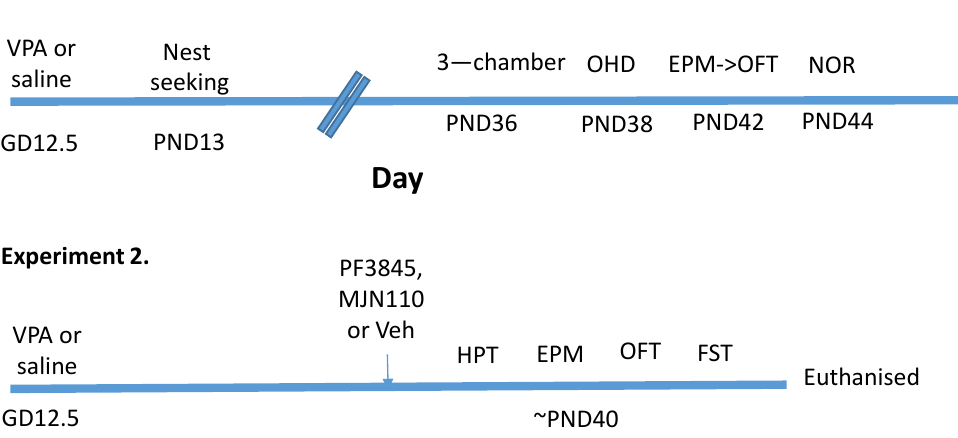
Figure 5. Schematic of the experimental design for the behavioural characterisation of male and female rats prenatally exposed to saline or VPA (experiment 1a–b) and examining the effect of enhancing AEA and 2-AG tone on nociceptive and affective behaviour in VPA-exposed female rats (experiment 2).